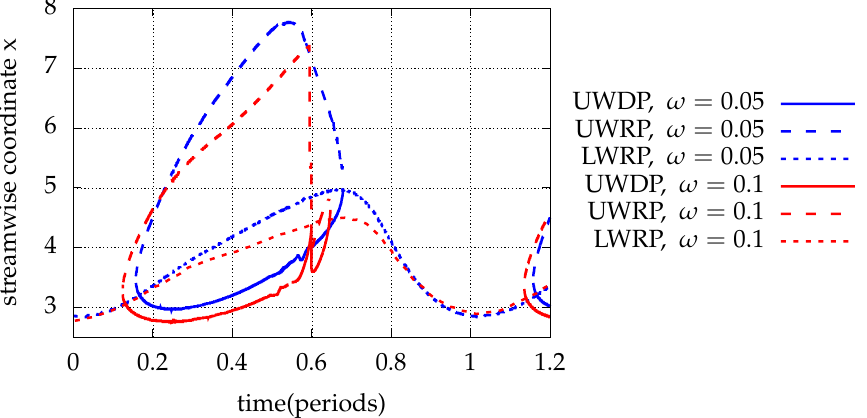
Figure 14. Upper wall detachment position (UWDP) and upper and lower wall reattachment positions (UWRP, LWRP) for unsteady periodic inflow with α = 0.05 and Re = 400 and oscillating part of the bottom wall with ω = 0.1, A = 0.2, l = 10. Comparison with results for ω = 0.05. A decrease in the amplitude of oscillation of the moving portion of the bottom wall ( A low = 0.15, A high = 0.2) causes the reduction in the upper wall separation region length. It also causes the presence of the upper wall recirculation for larger portion of the period and to the downstream movement of the respective detachment position. Furthermore, it leads to the reduction in lower wall reattachment position oscillation amplitude (Figure 15). The less upper wall and lower wall bubble length fluctuations is directly related to the reduced oscillation amplitude of the control surface. The remarks of Mateescu et al. [13] are in agreement with the aforementioned.